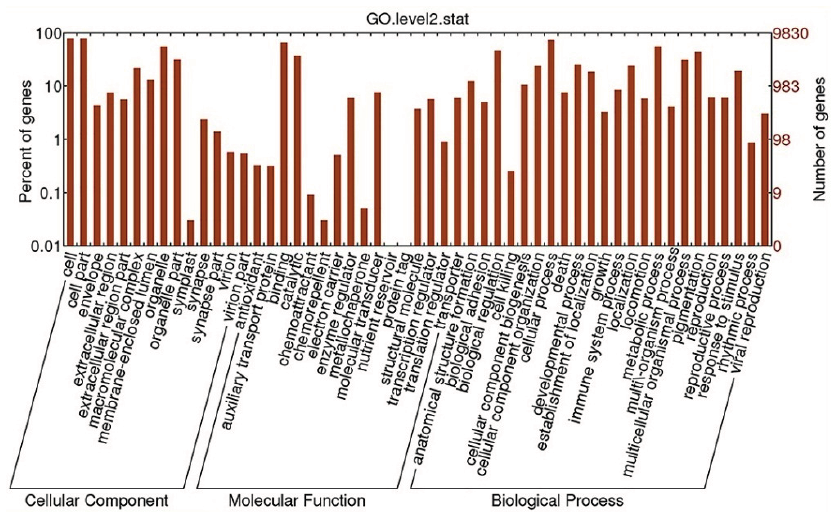
Figure 6. Histogram presentation of Gene Ontology classification. Unigenes were assigned to three categories: cellular components, molecular functions and biological